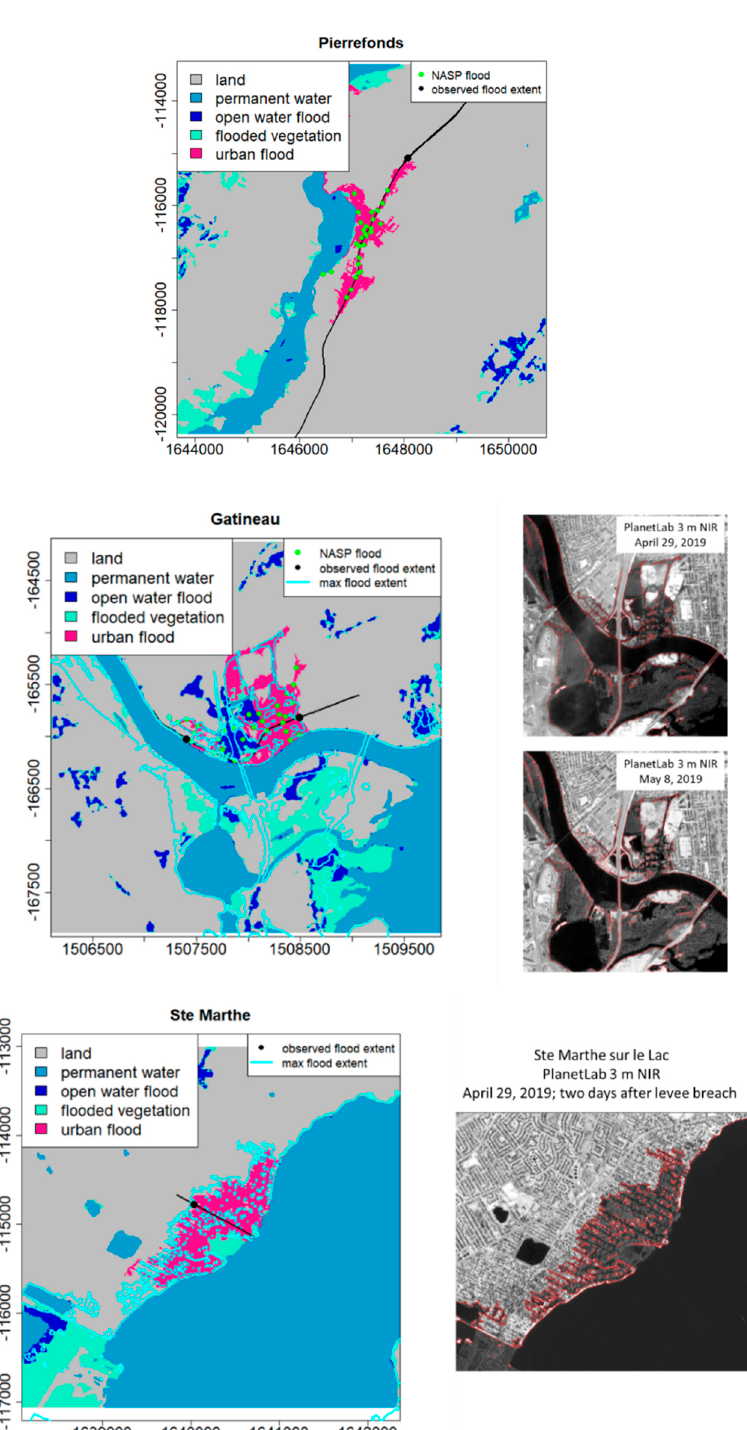
Figure 11. Validation of simulated flood extents from single flood perimeter observations combined with Lidar DEM data along roads in each of the three boroughs, using visual interpretation of NASP, corresponding high-resolution optical imagery (to the right of each simulation), and the 2019 maximum flood extent product outlined in light blue on maps and in red on